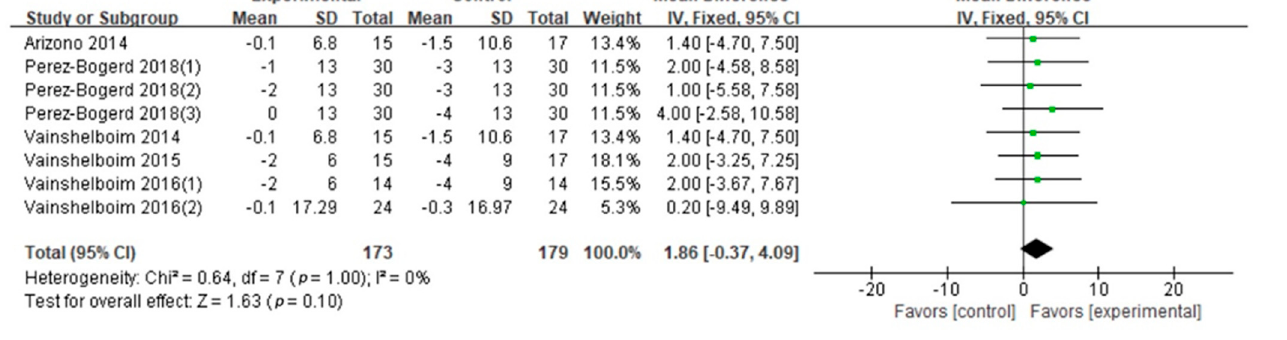
Figure 6. TLC% pred. 3.3. Quality of Life •